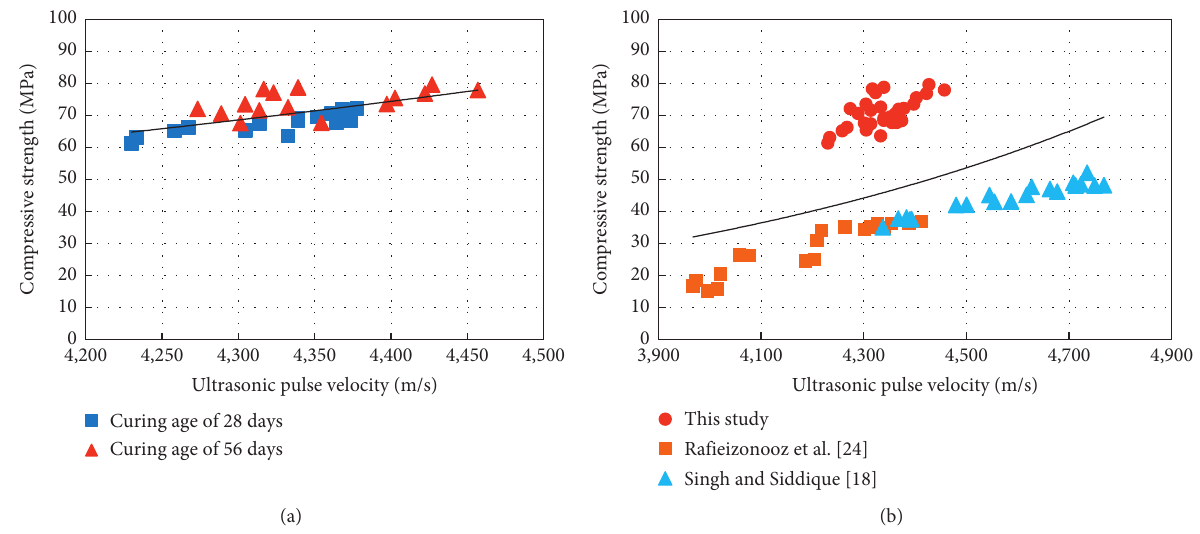
Figure 13: Relationship between the compressive strength and ultrasonic pulse velocity. (a) Test results in this study. (b) Test results in this study and previous studies.